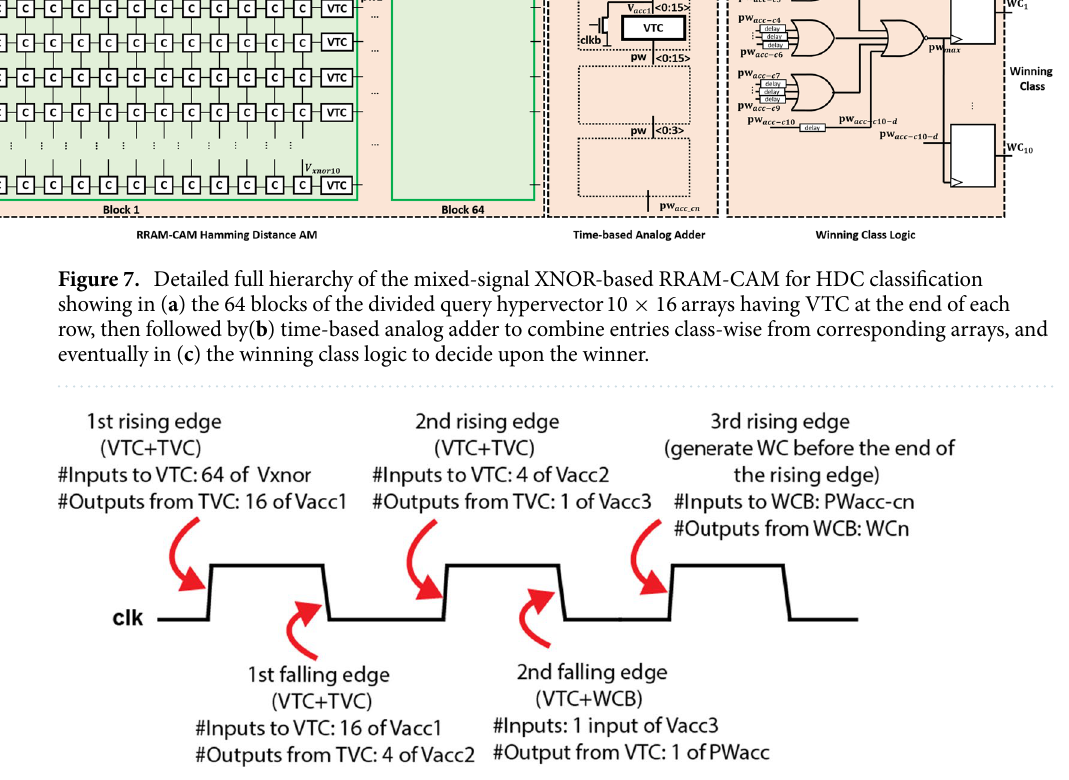
Figure 8. Timing diagram showing the input/output from each module of the full hierarchy of the mixed- signal XNOR-based RRAM-CAM at each rising